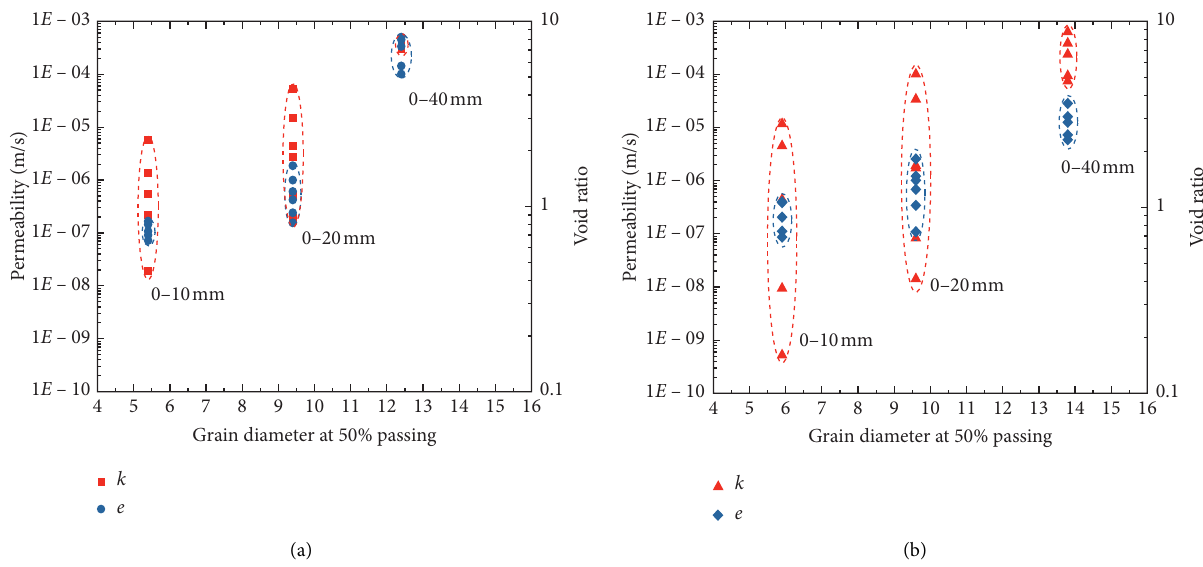
Figure 9: Relationship between permeability, void ratio, and average particle size. (a) P1-1, P1-2, and P1-3. (b) P2-1, P2-2, and